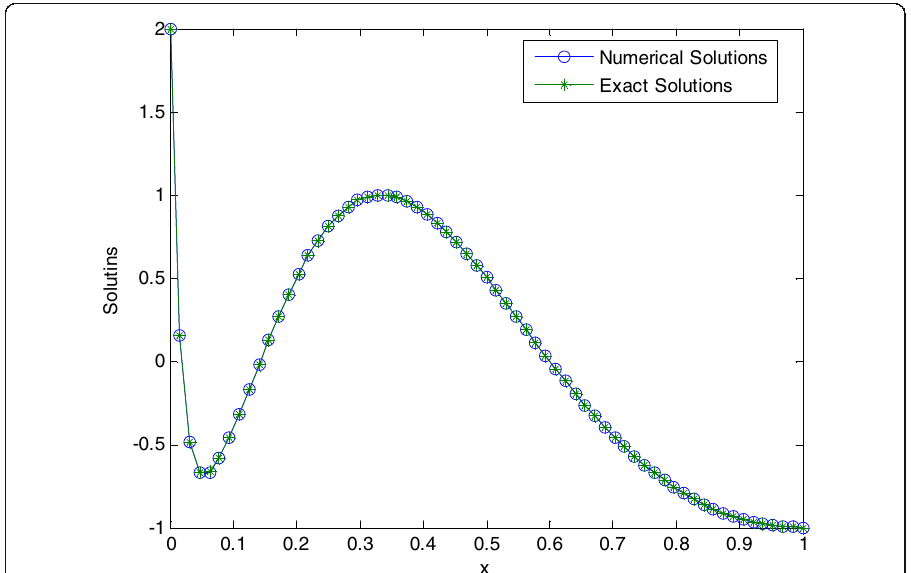
Fig. 2 The physical behavior of the solution for Example 2 at N = 64 and ε = 10 −